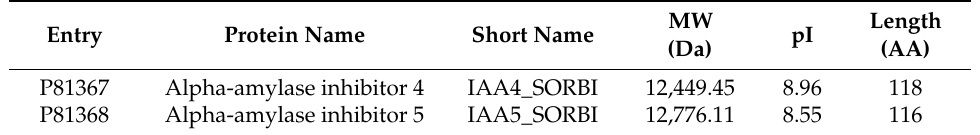
Table 3. List of sorghum α -amylase / trypsin inhibitor available from the online database UniProtKB, as of 15 November 2019. Both proteins are reviewed. MW is the molecular weight, pI the isoelectric point and AA is the number of amino acid residues. Entry Protein